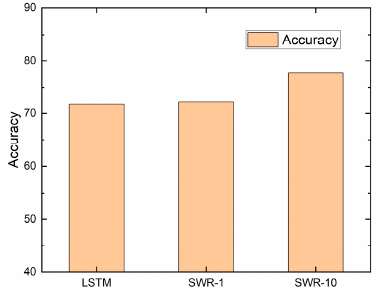
Figure 8. Accuracy. Figure 8. Accuracy.